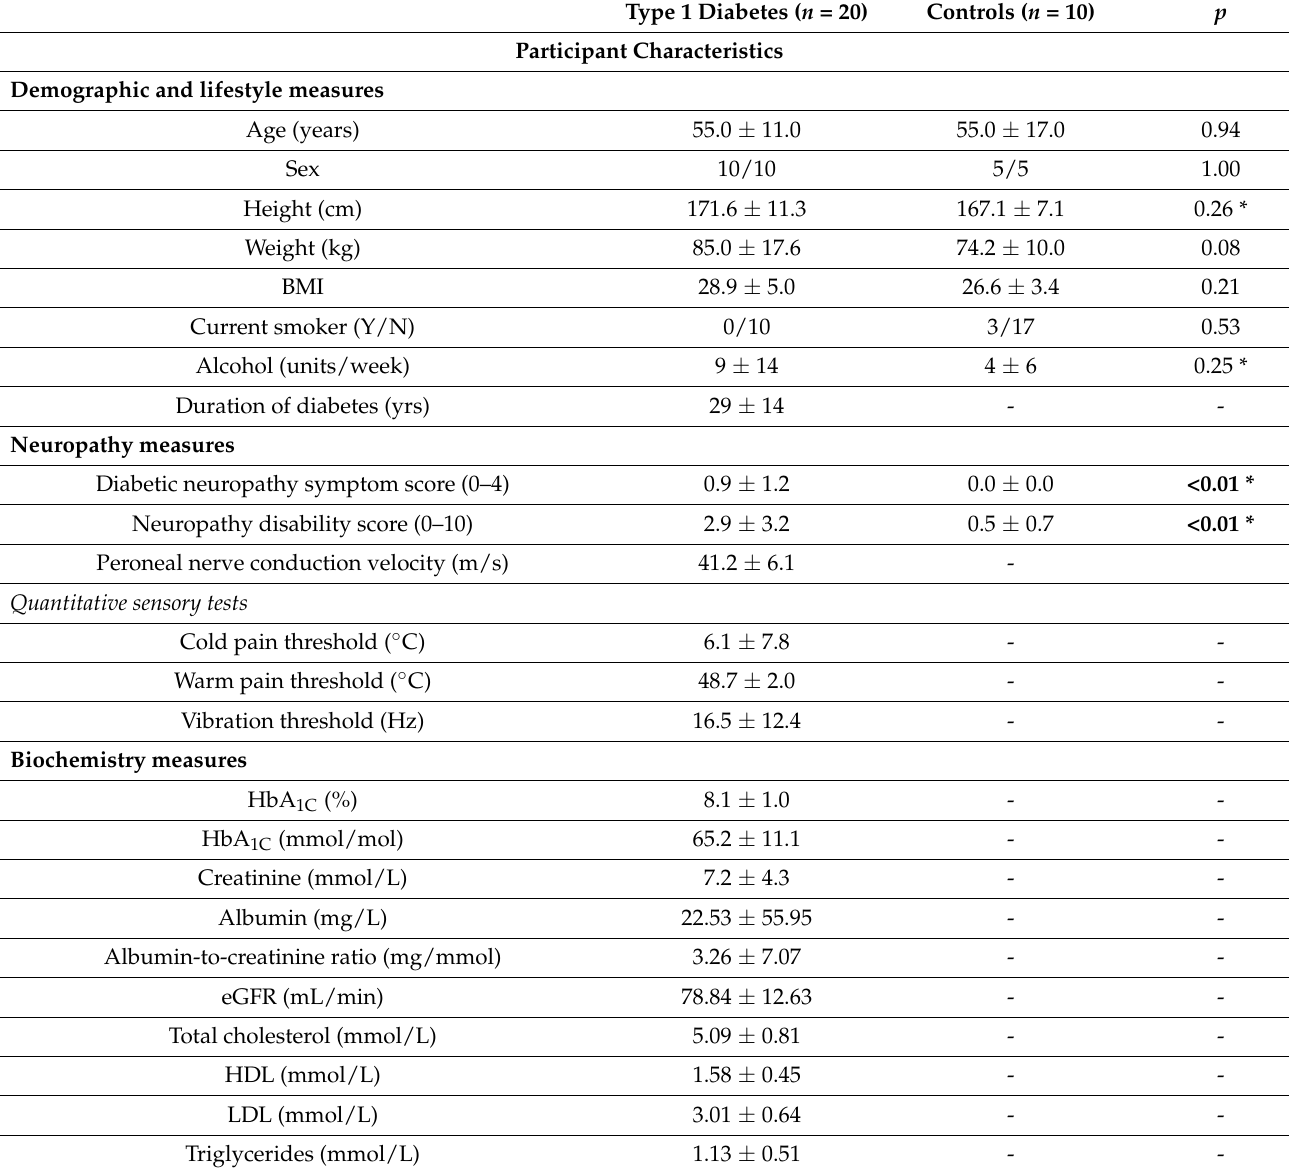
Table 1. Clinical, metabolic and neuropathy data presented as mean ± standard